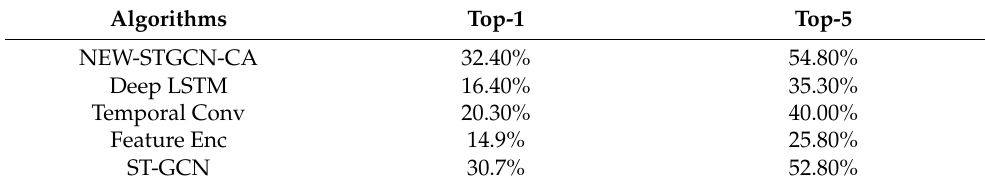
Table 2. Comparison of recognition accuracy of Kinetics-Skeleton dataset.